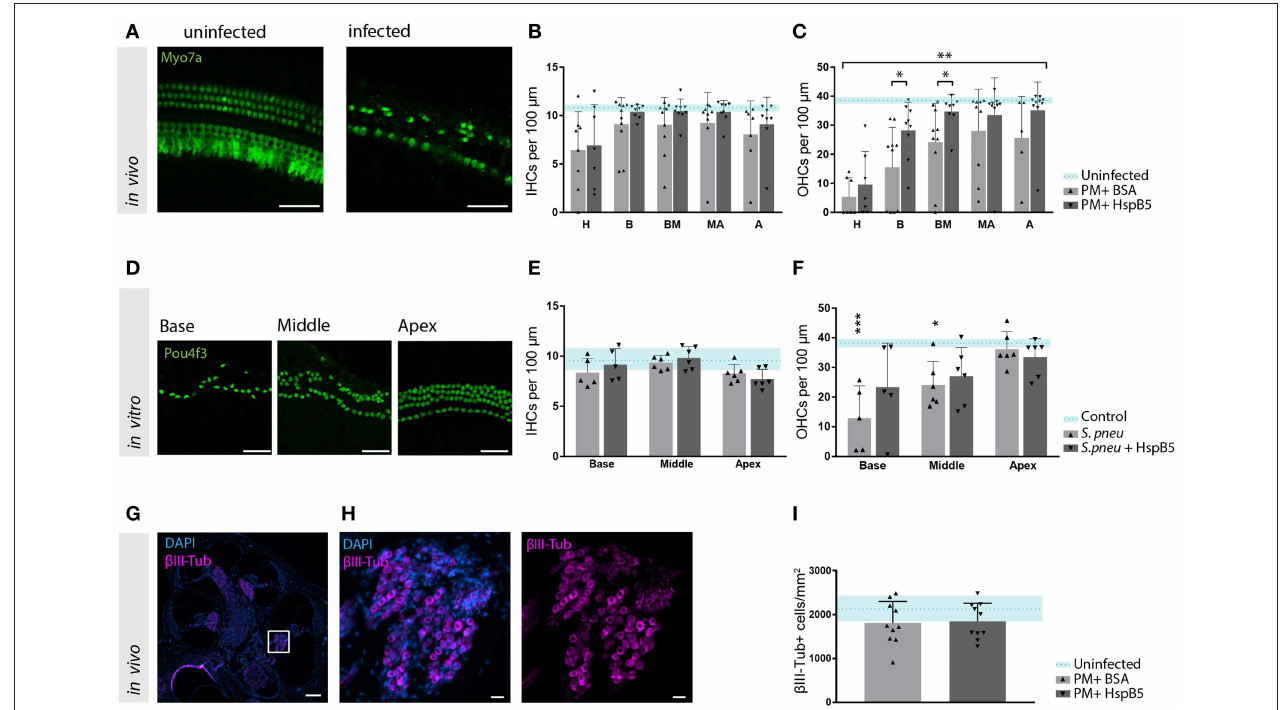
FIGURE 5 | HspB5 protects against S. pneumonia -induced sensory hair cell loss. (A) Representative example of a whole mount preparation of the organ of Corti stained with hair cells specific Myo7a (green), scale bar = 50 µ m (B) Quantification of inner hair cells and (C) outer hair cells at 4 weeks post infection, uninfected animals ( n = 3) indicated in blue as mean (blue dashed line) and standard deviations (blue shade), hair cell count of infected animals ( n = 10/group) represented in bar graphs. 7–10 whole mount preparations were quantified per cochlea; H, hook; B, base; BM, base-middle; MA, middle-apex; A, apex. (D) Representative confocal images of the organ of Corti immunostained for hair cells (Pou4f3, green) 4 days after exposure to S. pneumonia. Basal, middle and apical turns are shown, scale bar = 50 µ m (E) quantification of inner and (F) outer hair cells in vitro without bacteria n = 4 (light blue); untreated (gray) n = 6 and HspB5-treated (black) n = 6. (G) Mid-modiolar cross section of a control rat cochlea immunostained for the neuronal marker β III-Tubulin (magenta) and cell nuclei (DAPI, blue), scale bar = 200 µ m. (H) The Rosenthal’s canal in the basal turn is shown at higher magnification, scale bar = 20 µ m (I) Neuronal density quantification in the basal turn in uninfected ( n = 3), infected untreated or HspB5-tretaed ( n = 10 animals per group). Means with SD are indicted in the bar graphs. Dashed line with shade represents average count of uninfected cochlea with SD. A two-way ANOVA was used for determining interaction between variables and an unpaired t -test with Welch’s correction was used for single comparison between untreated and HspB5 treated (in B and C ) * p < 0.05; ** p < 0.01. A one-way ANOVA with Tukey’s multiple comparison test was used to evaluate whether the means of the population s differ in (E,F) * p < 0.05; *** p <